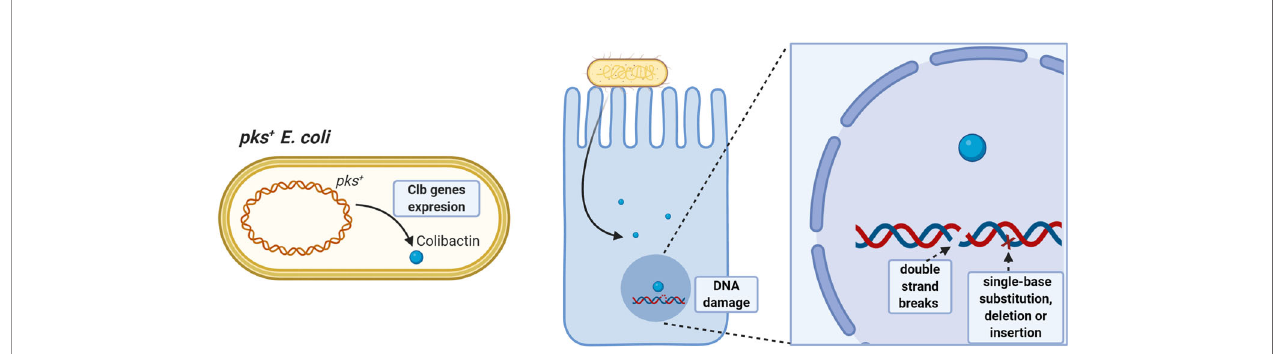
FIGURE 1 | Pro-tumorigenic effects of pks + E. coli. Strains having the pathogenicity island pks can synthesize colibactin toxin having oncogenic potential. Colibactin damages colonocyte DNA by inducing double-stranded DNA breaks and single-base substitution, deletion, and insertion mutations, favoring accumulation of damage and increasing the risk of malignant cell transformation.